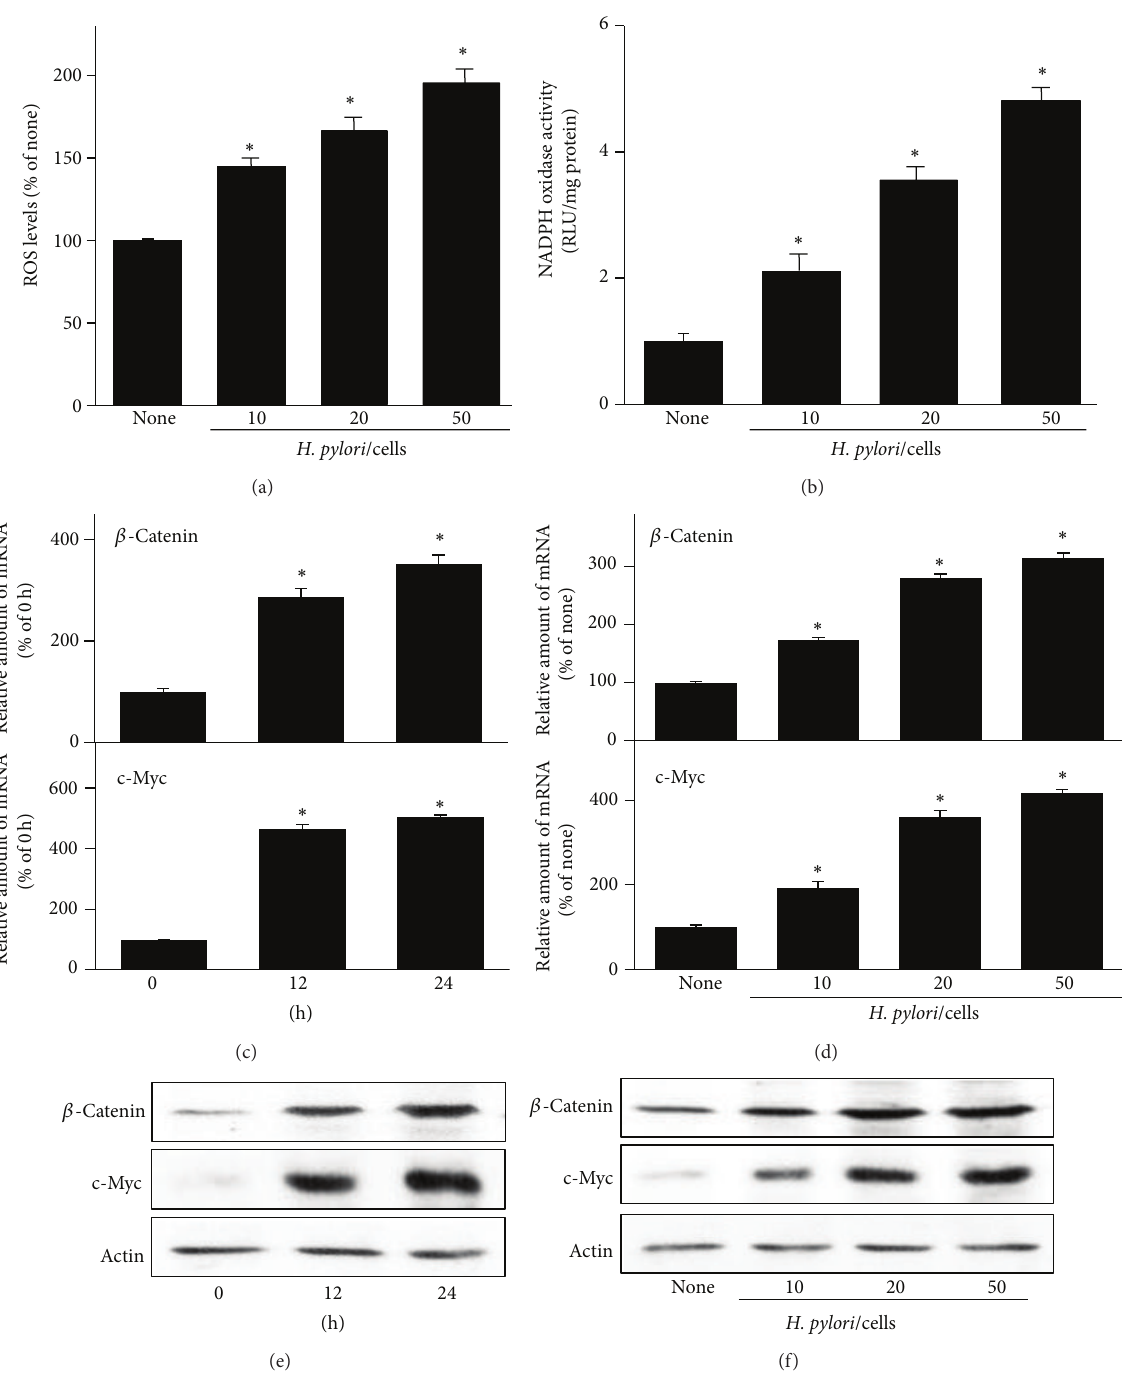
Figure 2: ROS levels, NADPH oxidase activity, and mRNA and protein levels of 𝛽 -catenin and c-myc in AGS cells infected with H. pylori. (a, b, d, f) The cells were cultured in the presence or absence of H. pylori (at bacterium/cell ratio of 10, 20, 50 :1) for 24 h. (c, e) AGS cells were cultured in the presence or absence of H. pylori (bacterium/cell ratio of 50 : 1) for the indicated time period. (a) ROS levels were determined by DCF fluorescence after 30 min of H. pylori infection. The levels of ROS trapped in the cells and cultured in the absence of H. pylori (none) are considered as 100%. (b) NADPH oxidase activity was determined by lucigenin assay using membrane extracts of the cells. NADPH oxidase activity was also monitored by addition of cytosolic extracts to the reaction mixture as a negative control. (c–f) mRNA and protein expression were determined by real-time PCR and Western blot analysis, respectively. Actin served as a loading control. ∗ 𝑃 < 0.05 versus 0h or none (the cells cultured in the absence of H. pylori